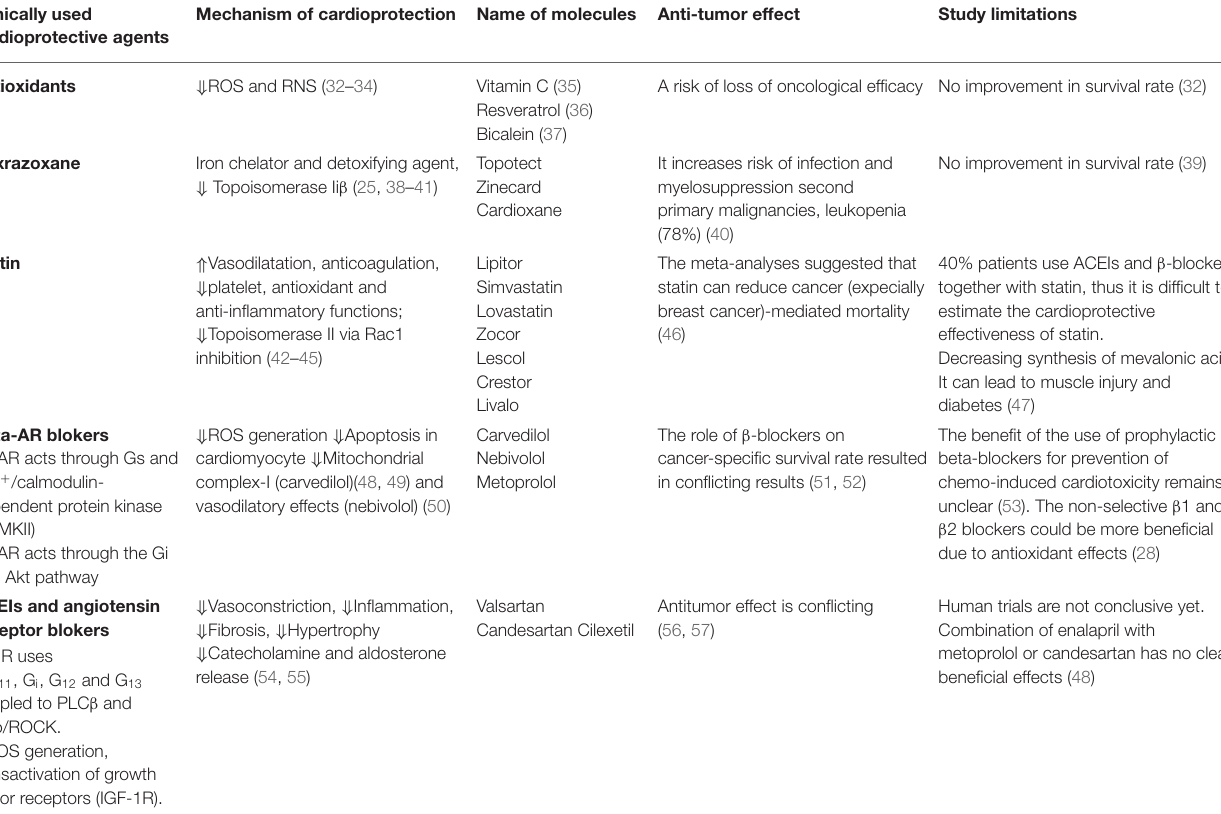
TABLE 1 | Prophylactic cardioprotective agents. Clinically used Mechanism of cardioprotection Name of molecules Anti-tumor cardioprotective agents